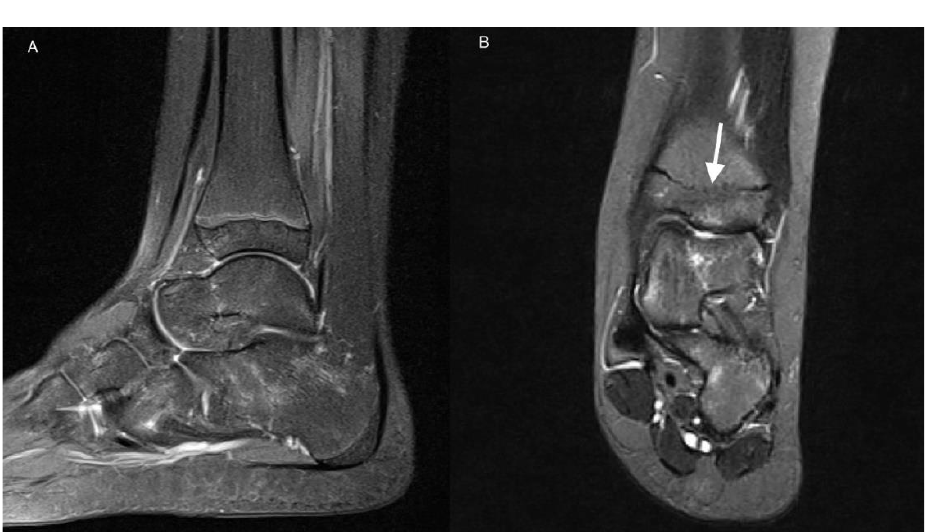
Figure 2. MRI of the left ankle of an 11-year-old girl with JIA. T2-weighted TIRM images in sagittal ( A ) and coronal ( B ) planes. Patchy BME (stage 1) in talus and calcaneus. Developmental disorder in the form of premature closure of physis (arrow).